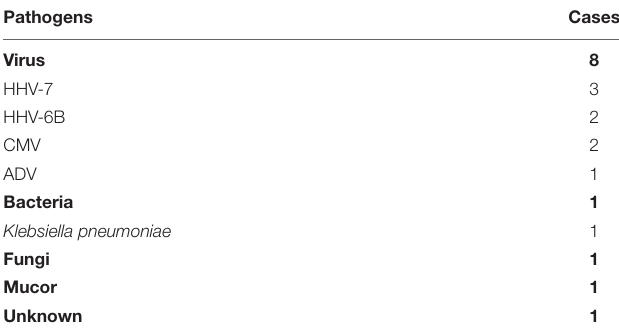
TABLE 4 | The spectrum of pathogens in CNS infections by mNGS ( n =